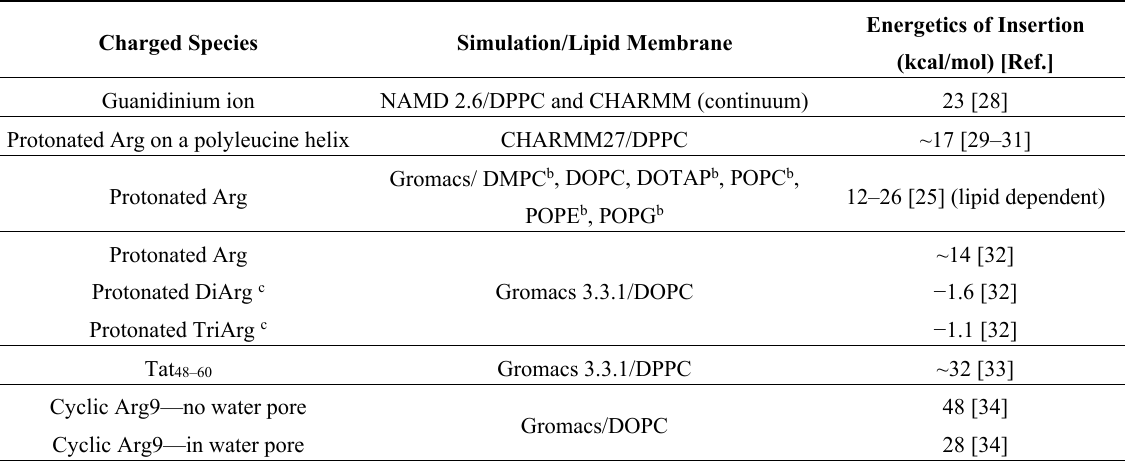
Table 3. Cost of placing charged residues at the bilayer center a